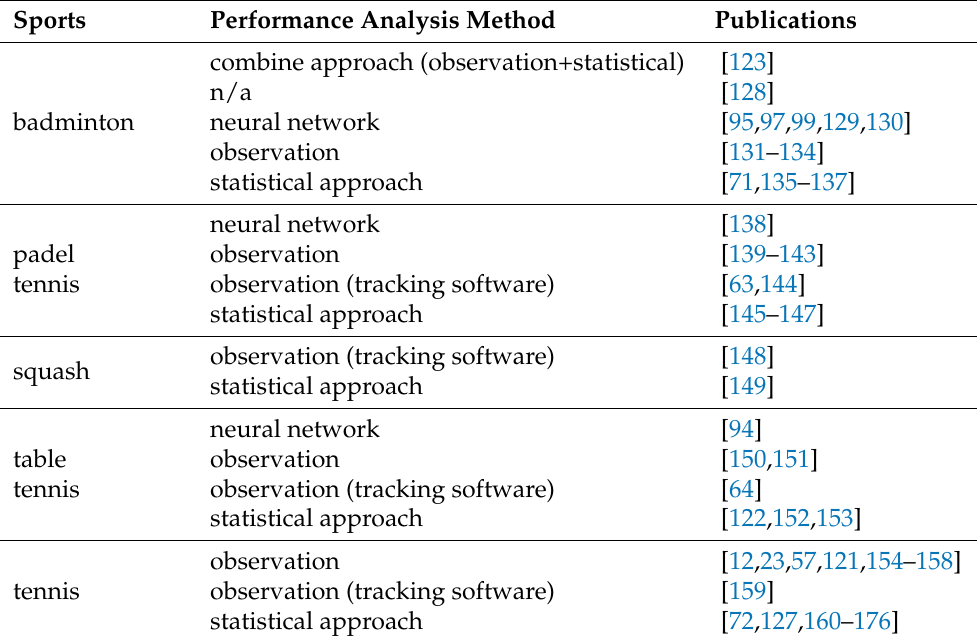
Table 3. Distribution of the performance methodology for each racket sport.